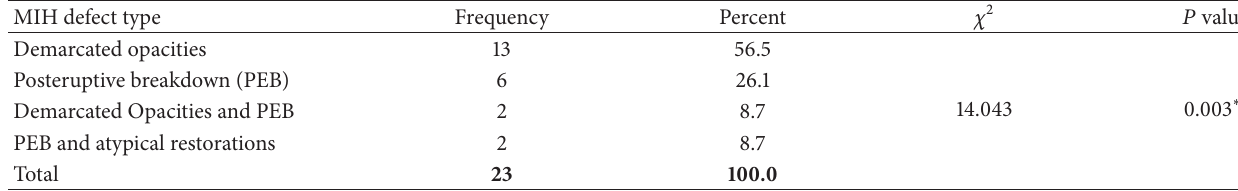
Table 3: Prevalence of MIH according to diagnostic criteria.